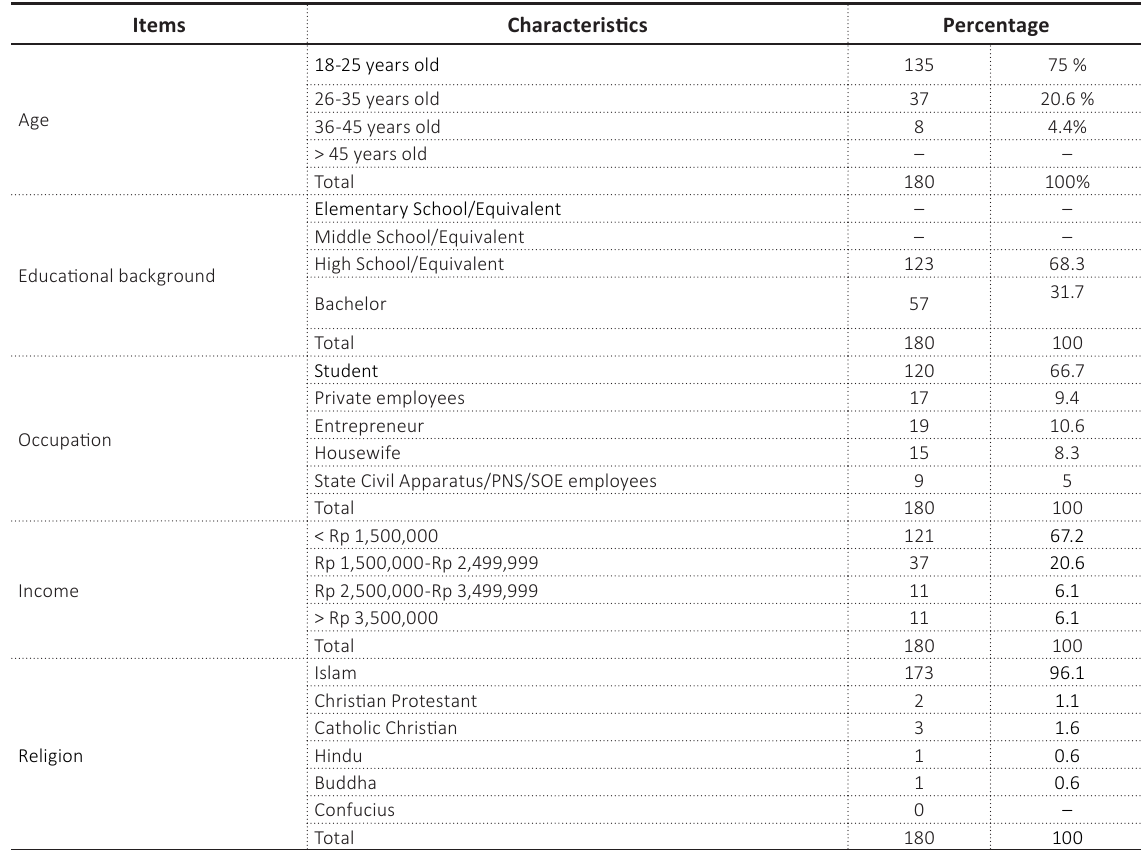
Table 2. Characteristics of